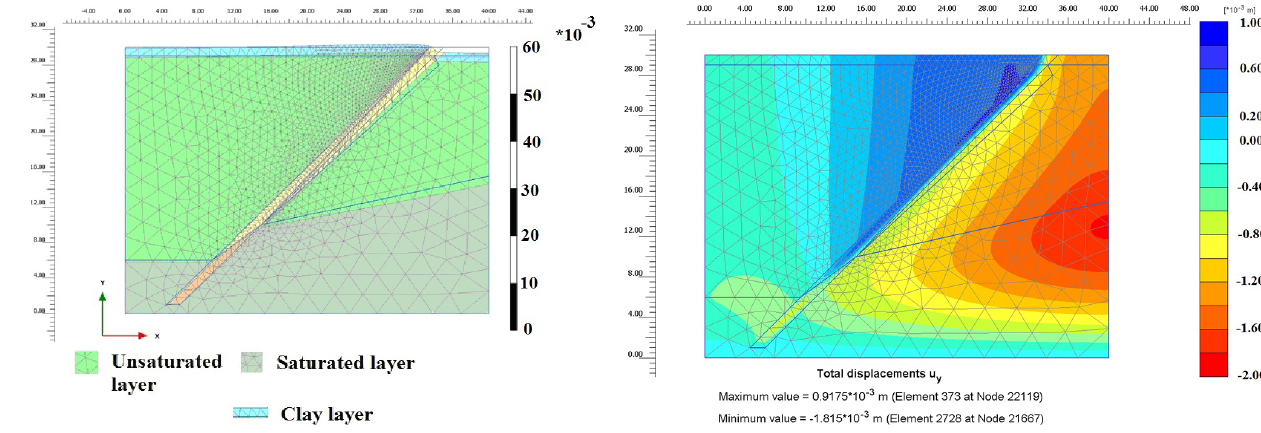
Figure 5. Deformed mesh after water extraction (left). Maximum total vertical displacement after water extraction (right).